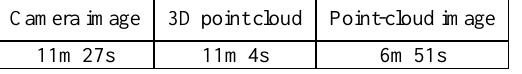
Table 1. Annotation time by the